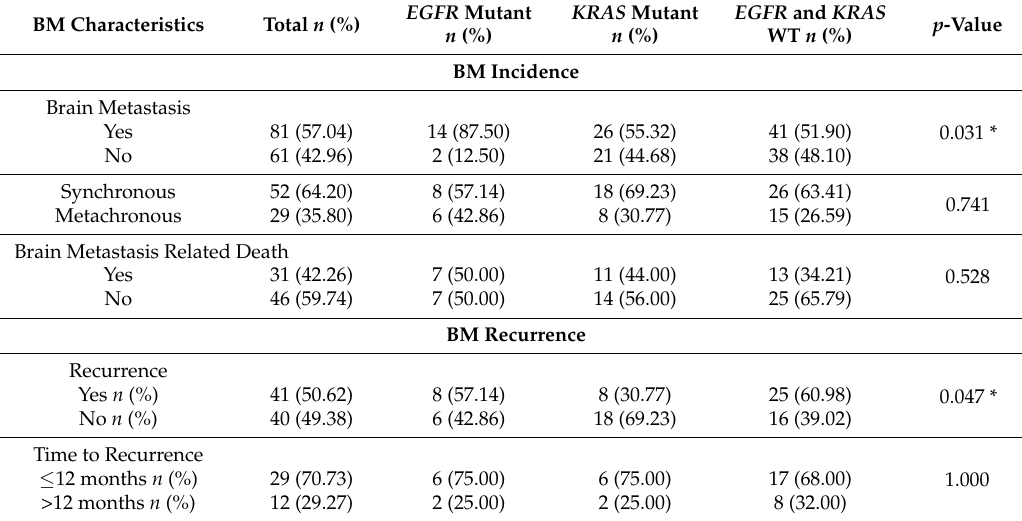
Table 2. Association between mutation status and brain metastasis incidence and recurrence. WT: wild type; BM: brain metastases; *: significant p -value.